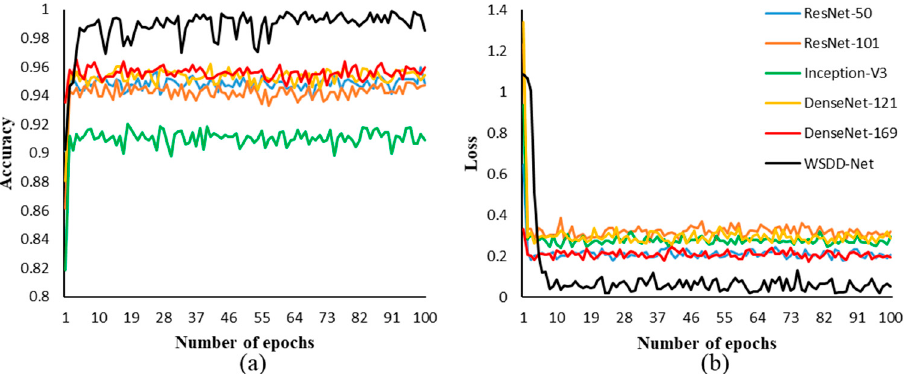
Figure 6. Training process curves of ResNet-50/101, Inception-v3, DenseNet-121/169, and WSDD-Net. ( a ) Accuracy curve and ( b ) loss curve.